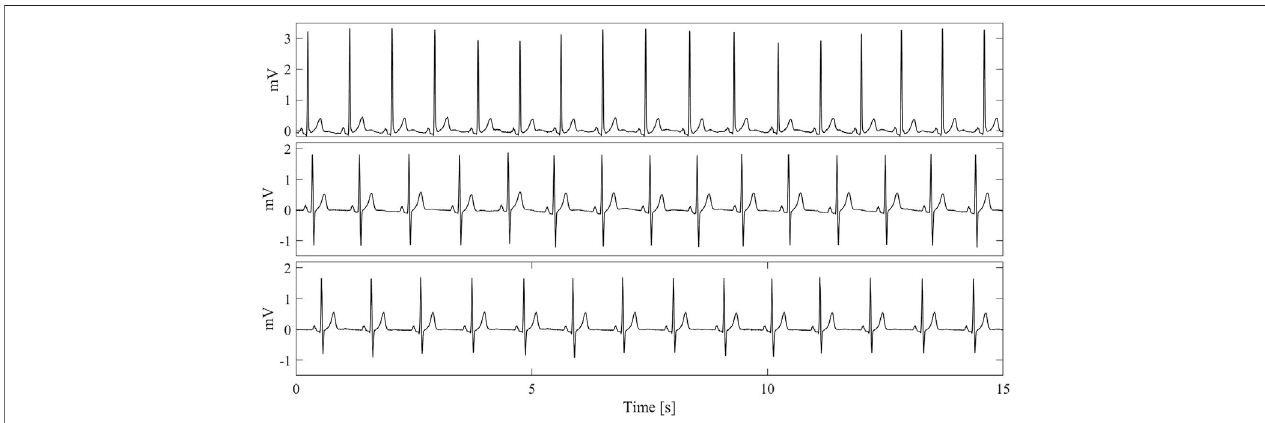
FIGURE8| Examplesof15s-longECGrecordingswiththehighestqualitativescoreforthedifferentelectrodetypes(assuch,theyaretakenfromdifferentsubjects and not simultaneously). From top to bottom: lead II recorded by a pair of commercial gelled Ag/AgCl electrodes (upper plot), non-breathable tattoo electrodes (middle plot) and breathable tattoo electrodes (lower